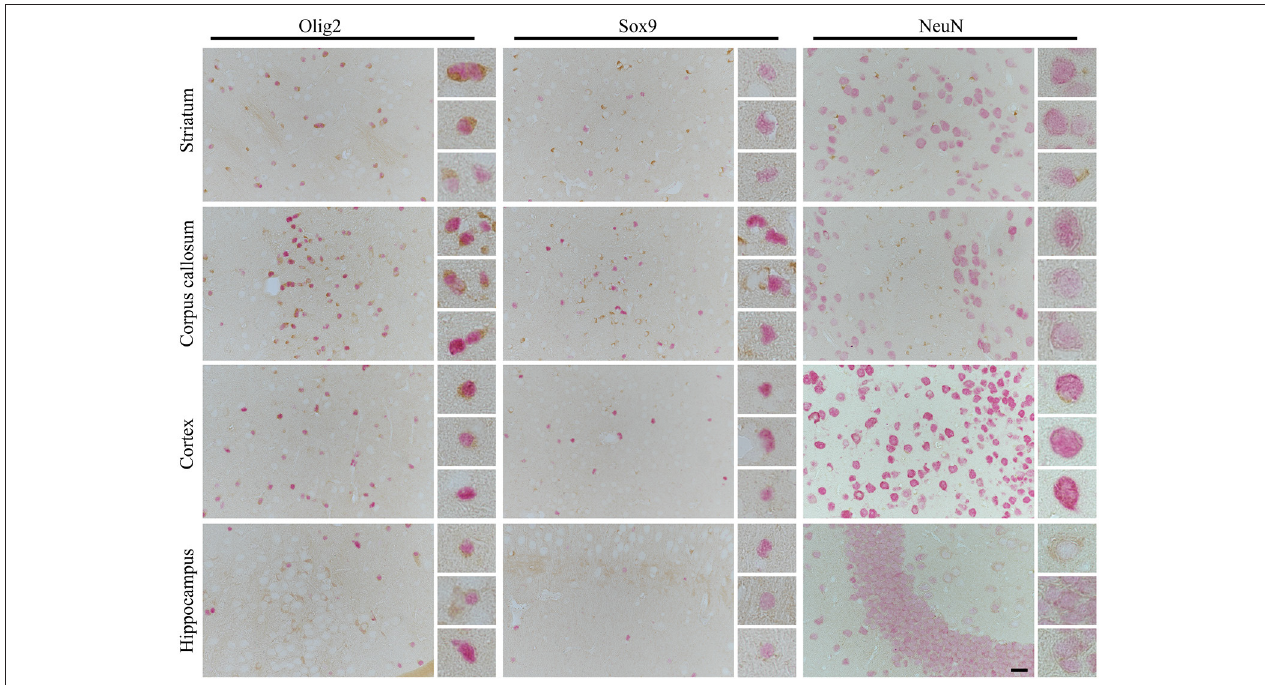
FIGURE 4 | The cell- and side-specific expression of four repeats of tau (4R) isoform in hTau animals brain. The high-power microphotography of double immunohistochemistry staining of 4R tau isoform (RD4, brown chromogen) combined with oligodendrocytes (Olig2, left panel, red/pink chromogen), astrocytic (Sox9, middle panel, red/pink chromogen) or neuronal (NeuN, right panel, red/pink chromogen) markers. The representative pictures of four brain regions: striatum (upper panel), corpus callosum (second upper panel), cortex (third upper panel), and hippocampus (lower panel) with higher magnification of representative cells on the right side of each image. In striatum and corpus callosum only oligodendrocytes were RD4 positive, and no RD4 immunoreactive astrocytes or neurons were detected. In cortex only, some oligodendrocytes and rear neurons were RD4 positive, and no RD4 immunoreactive astrocytes were identified. Similarly, in the hippocampus, no astrocytes were RD4 positive, and only some oligodendrocytes and neurons were weakly RD4 immunoreactive. The scale bar represents 25 µ m and applies to all pictures; inserts represent 4 × digital